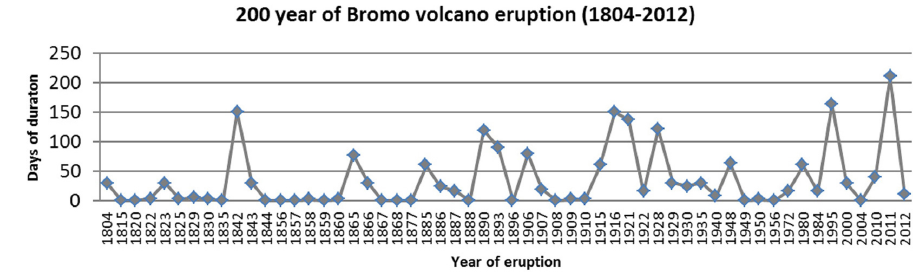
Figure 3. Year and duration (days) of Mt. Bromo eruption in a 200-year period (for 1804–2010, CVGHM 2010; and for 2011–2012, Field survey,